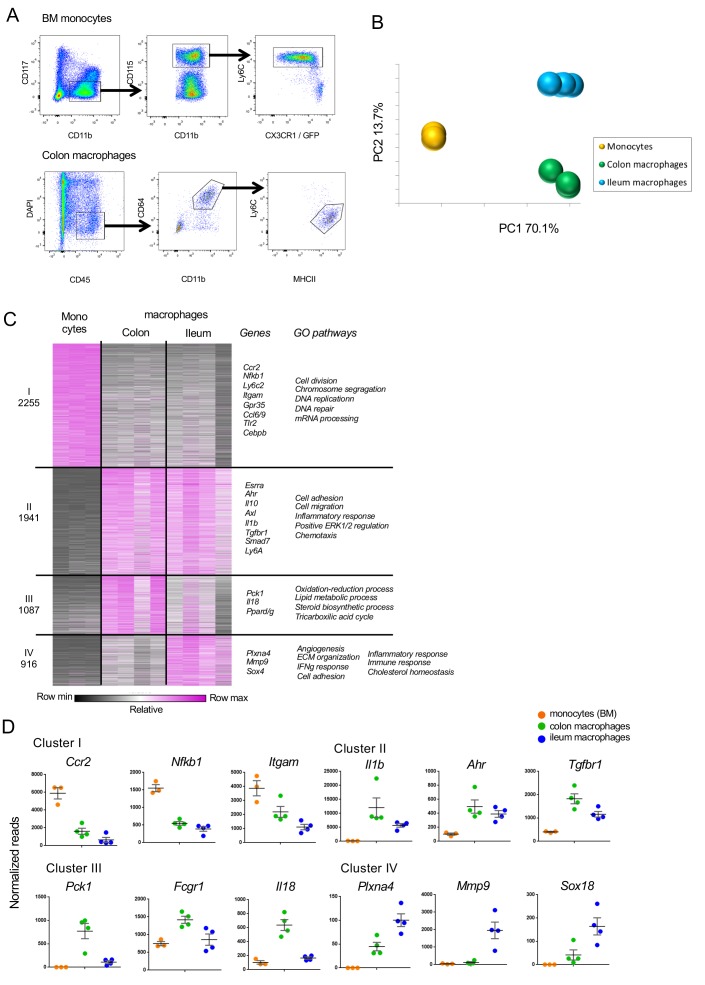
Comparison of gene expression in monocytes and resident colonic and ileal macrophages.(A) Sorting schemes for BM Monocytes and resident intestinal macrophages isolated from CX3CR1-heterozygous CX3CR1GFP/+ C57BL/6 mice according to the following surface markers: CD117-CD11b+ CD115+ Ly6Chigh CX3CR1/GFPint (monocytes); DAPI- CD45+ CD11b+ CD64+ Ly6C-MHCII+ (macrophages). (B) Principal component analysis (PCA) of all 12346 genes expressed in BM monocytes and resident macrophages from the colon ad ileum of CX3CR1+/gfp mice. Analysis was performed in MATLAB. BM monocytes (n = 3); colon, ileum macrophages (n = 4, each) (Suppl. file 1, data sets 1, 2, 5).) (C) Heat map of transcriptomes and representative genes. 6200 genes that show at least two fold change across all samples in the dataset divided to four clusters by the K-means algorithm in MATLAB. Visualization performed in Gene-E. (Suppl. file 1, data sets 1, 2, 5). GO pathway analysis of clusters. (D) Example genes for the clusters in (C).